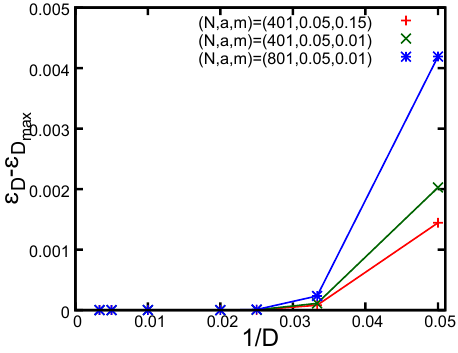
Figure 10 . The bond dimension dependence of the ground state energy. The parameter set of simulations is ( N, a, m lat . ) = ( 401 , 0 . 05 , 0 . 15 ) (red, +), ( 401 , 0 . 05 , 0 . 01 ) (green, × ) and ( 801 , 0 . 05 , 0 . 01 ) (blue, ∗